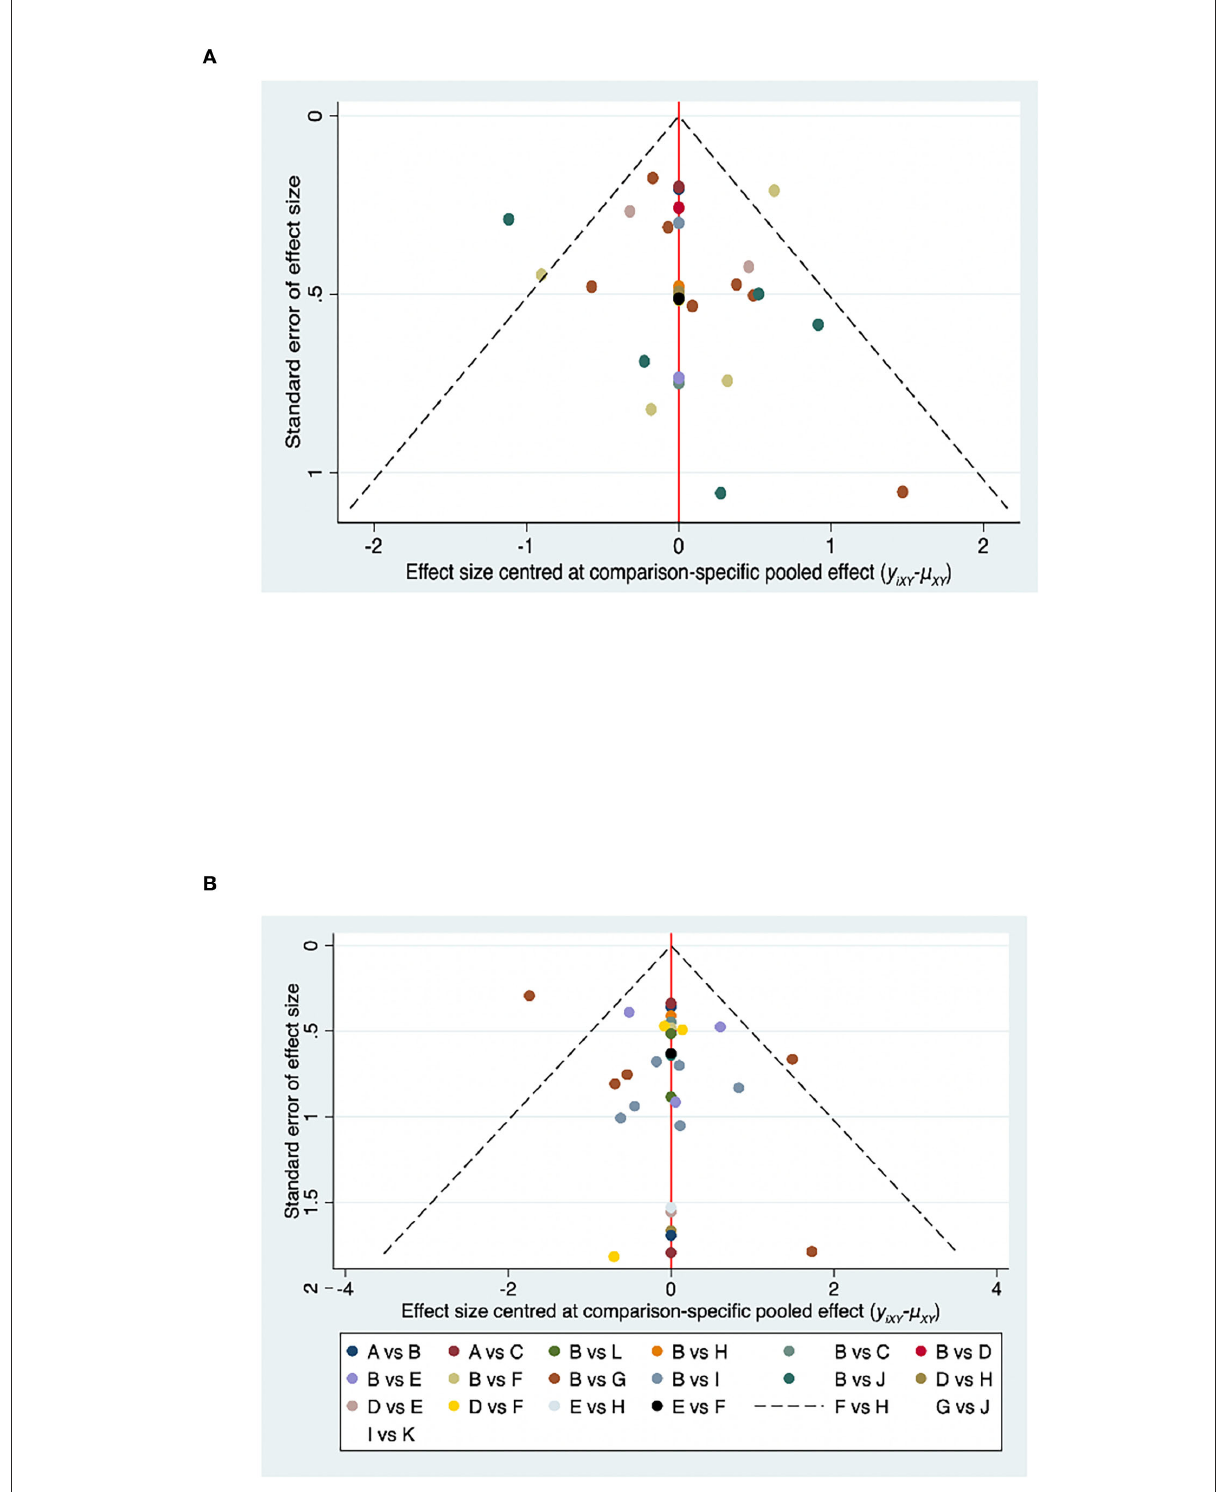
FIGURE6 Funnel plot of MMSE and MoCA for the network meta-analysis. (A) Funnel plot of MMSE for the network meta-analysis. (B) Funnel plot of MoCA for the network